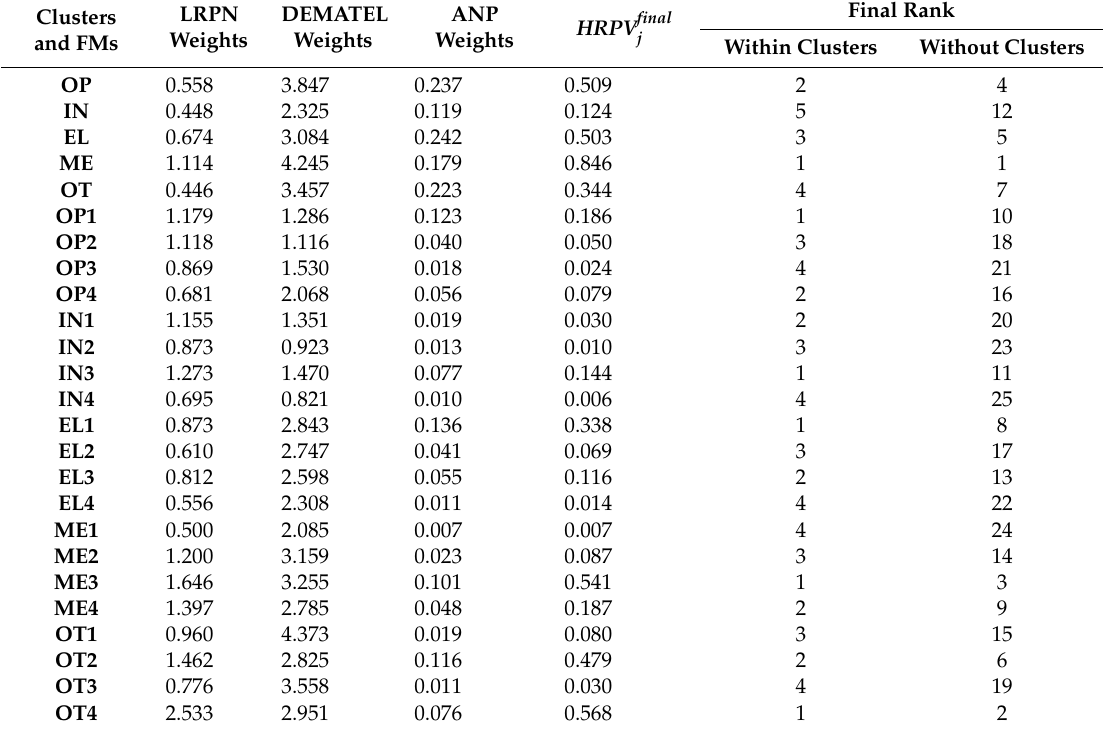
Table 13. The final hybrid risk priority value of clusters and FMs.